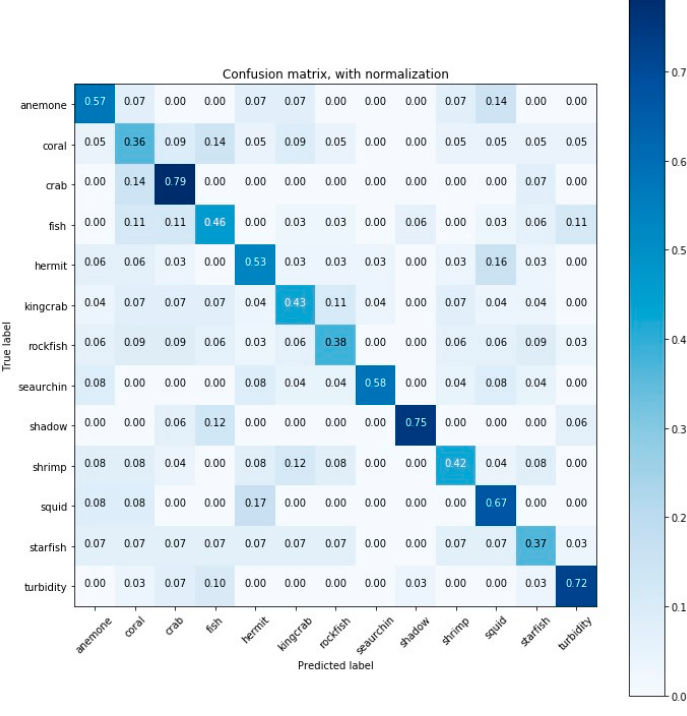
Figure A7. Confusion matrix for the classification results (accuracy) obtained by RF-1.